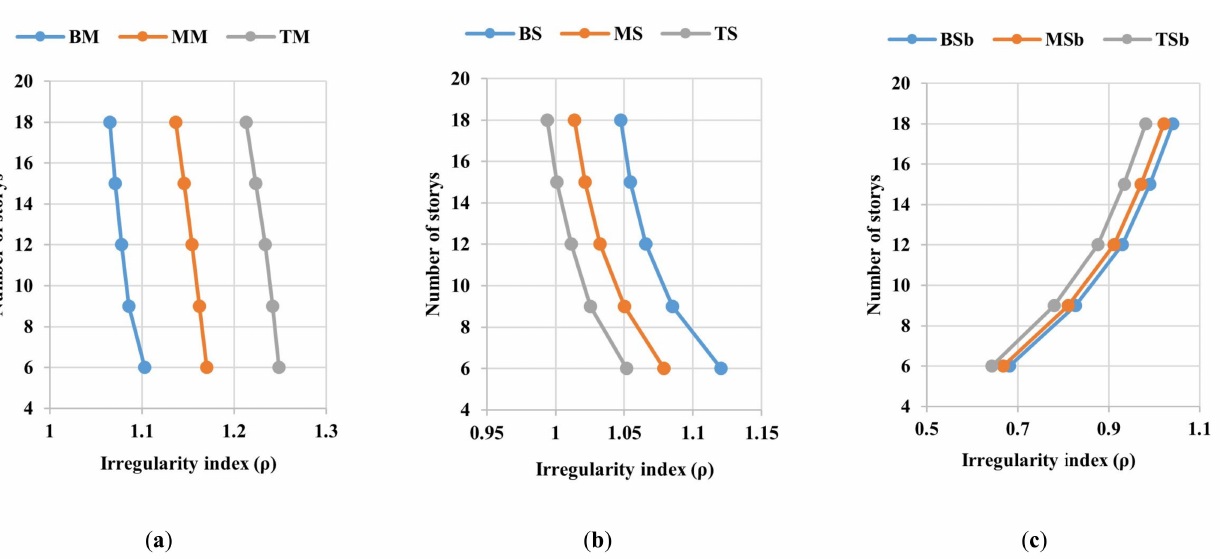
Figure 13. Relationship between the number of stories and the proposed irregularity index: ( a ) mass irregularity; ( b ) stiffness irregularity; ( c ) setback